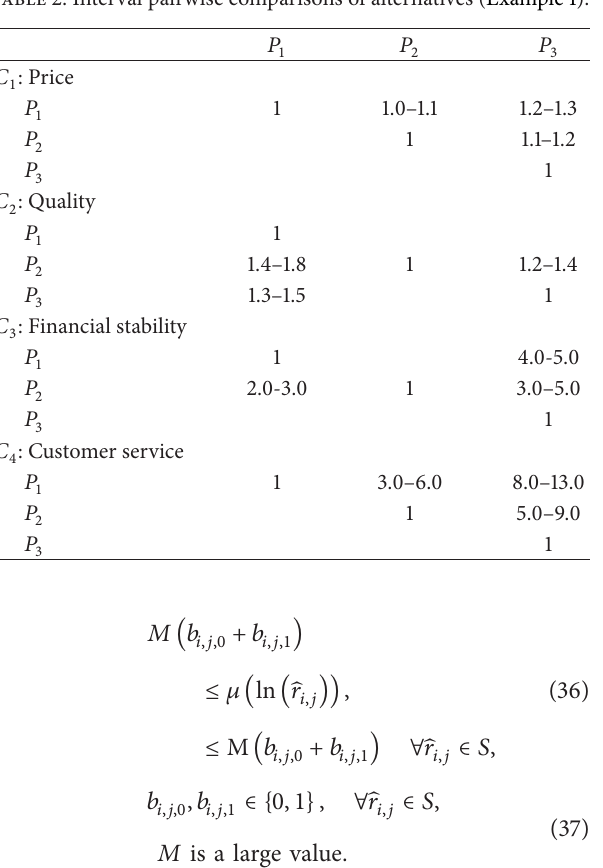
Table 2: Interval pairwise comparisons of alternatives (Example